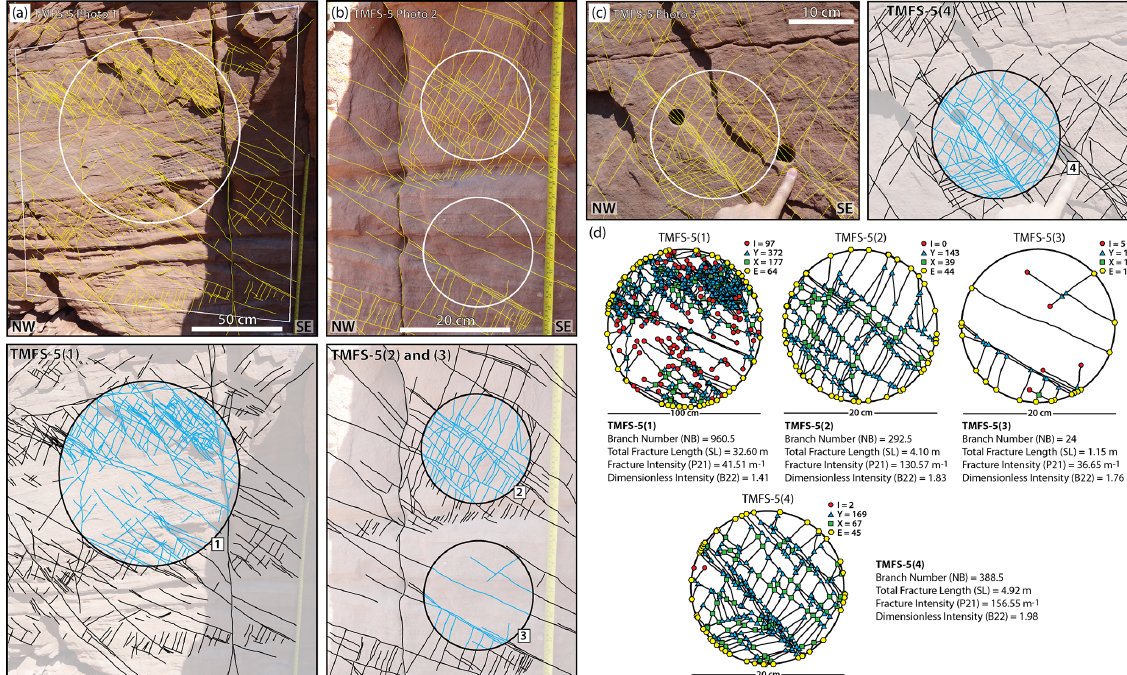
Figure A5. Sample station TMFS-5 scan circles (a, b, c) and nodal analysis (d) with statistics.